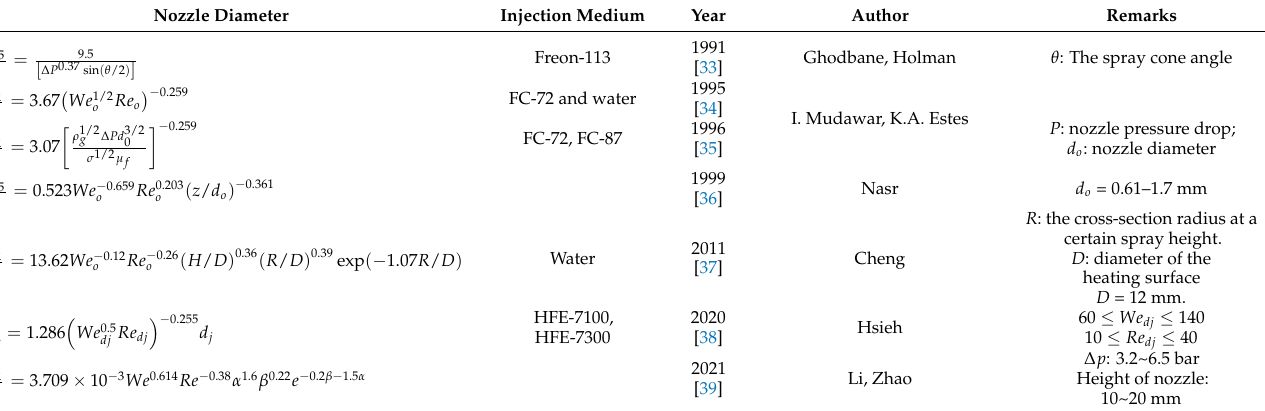
Table 1. The relationship between average diameter and true